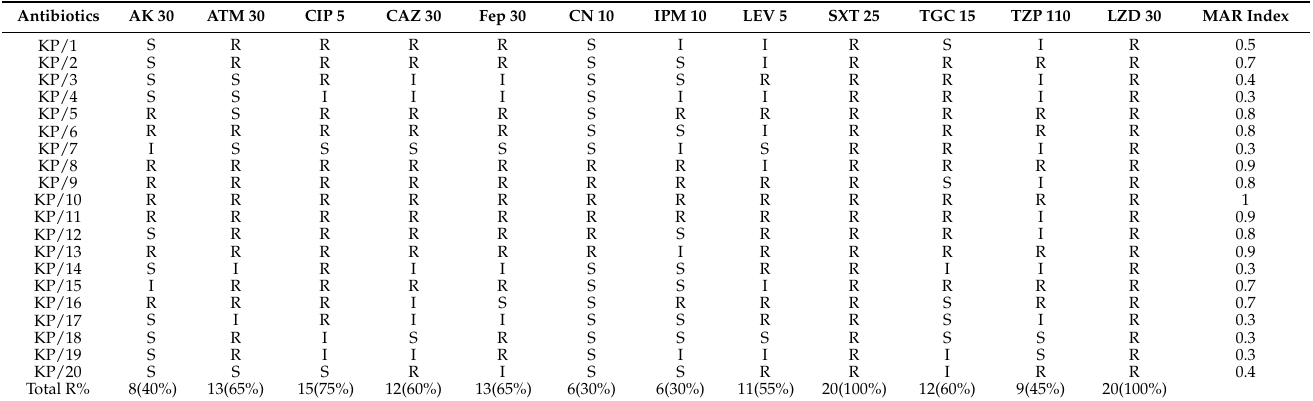
Table 1. Antibiotic sensitivity profile for K. pneumoniae isolates over 12 different antibiotics.